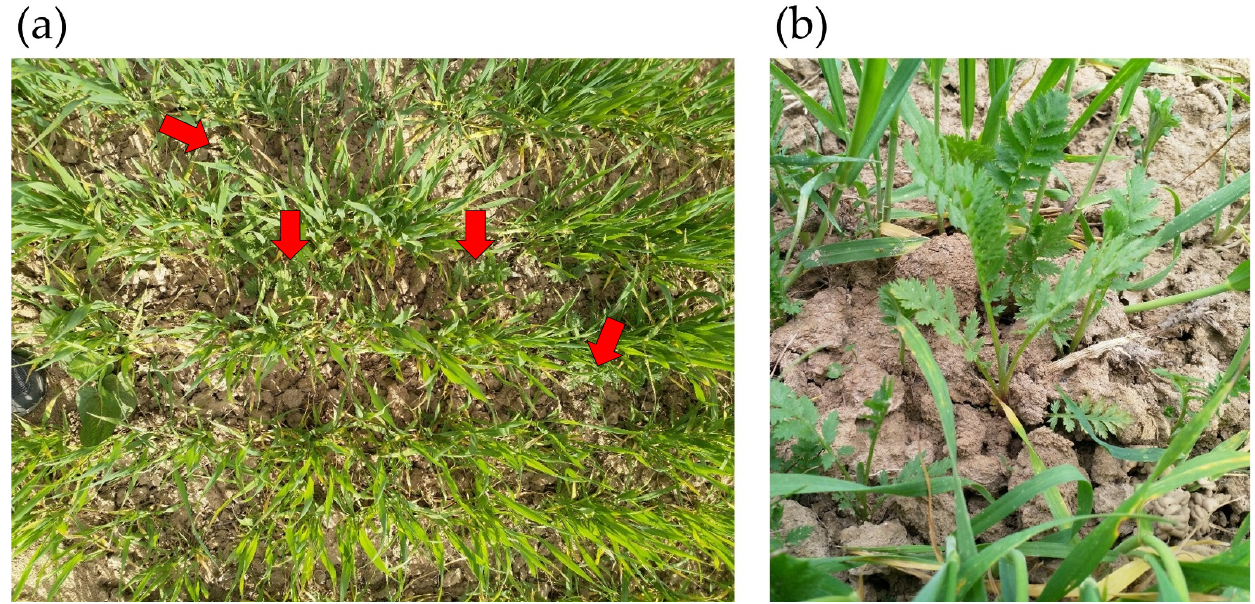
Figure 7. Observations of common tansy in winter wheat from above ( a ) (red arrows indicate a few individuals of the common tansy) and close-up ( b ). Photos were taken on 21 April 2022.